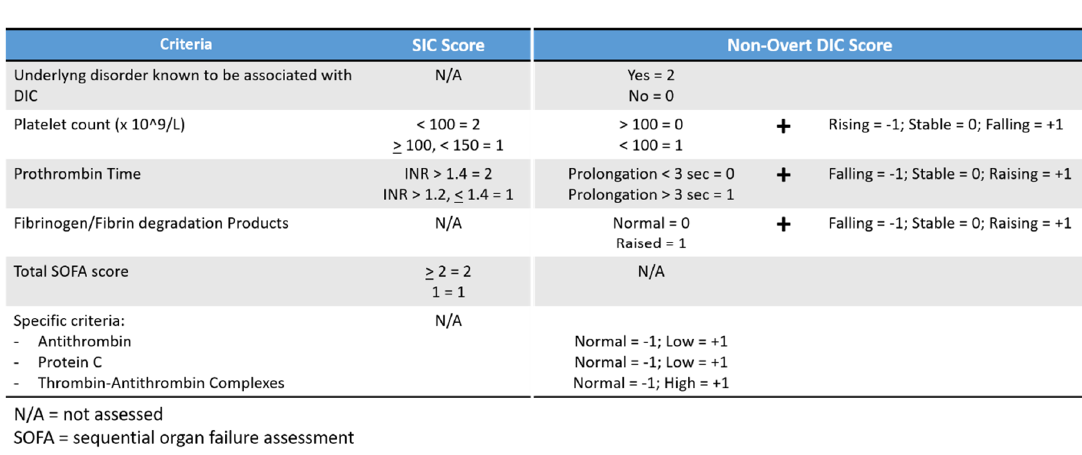
Figure 2. Algorithm that was used in our case series for the screening of overt and non-overt DIC, according to the recommendation of the International Society of Hemostasis and Thrombosis (ISTH). Primary outcomes were the occurrence of thrombotic complication, death, and worsening respiratory function requiring non-invasive ventilation (NIV) or admission to ICU during the hospital stay. These outcomes were correlated to the results of the SIC score, the overt DIC score, and non-overt DIC score.